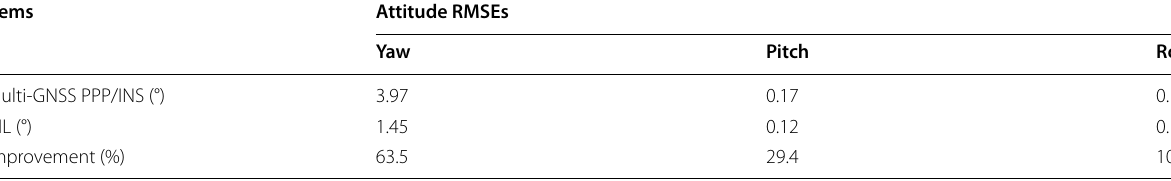
Table 6 RMSEs of attitude for multi-GNSS PPP/INS and GIL solutions in GNSS partly-blocked